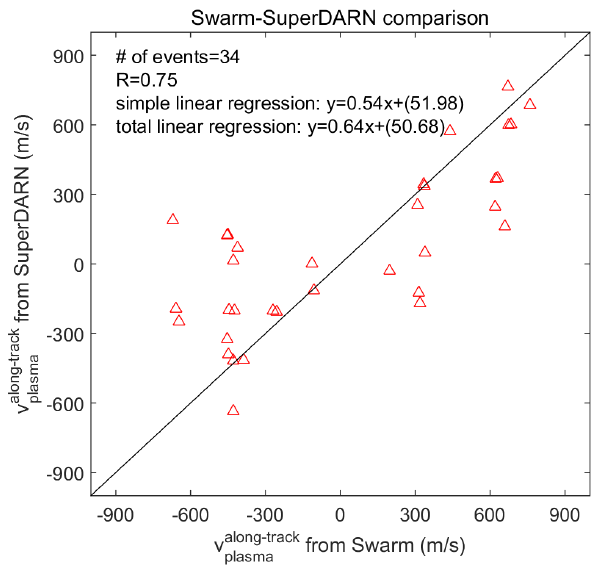
Figure 5. Correlation diagram for the along-track plasma drift speed obtained by Swarm and SuperDARN. The diagonal line rep- resents perfect correspondence between the abscissa and